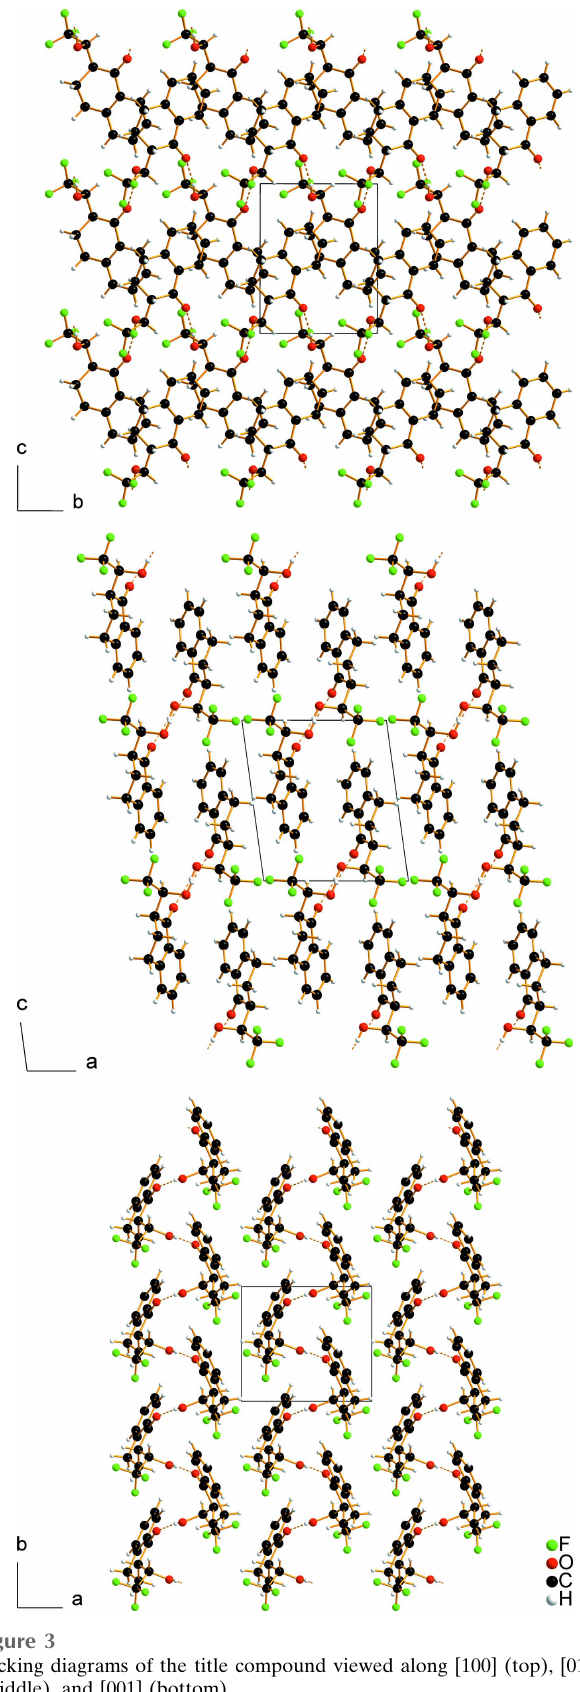
Figure 2 Intermolecular O—H (cid:2)(cid:2)(cid:2) O C hydrogen bonds connect the molecules into infinite zigzag chains running parallel to [010].